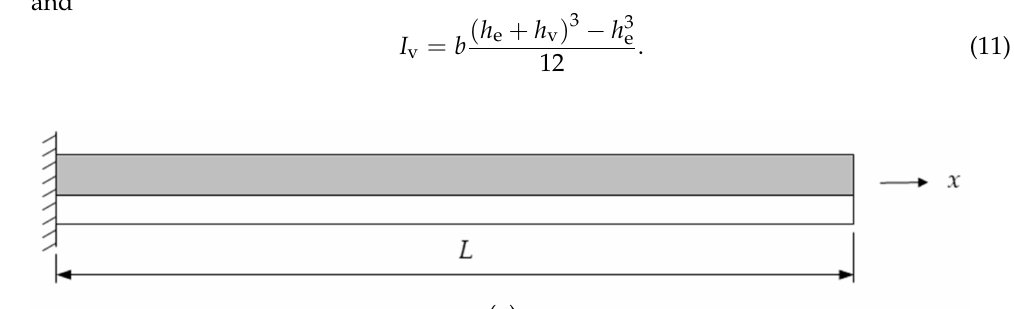
Mathematics 2021 , 9 , x FOR PEER REVIEW